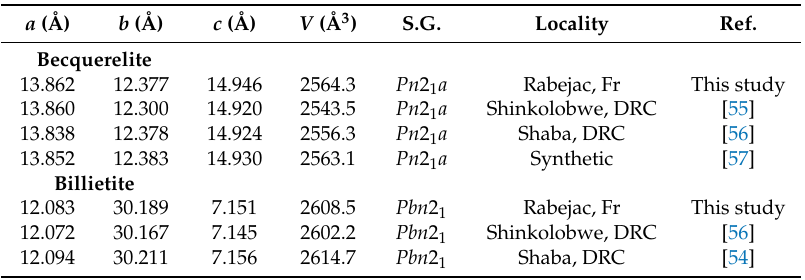
Table 14. Unit-cell parameters of becquerelite and billietite.